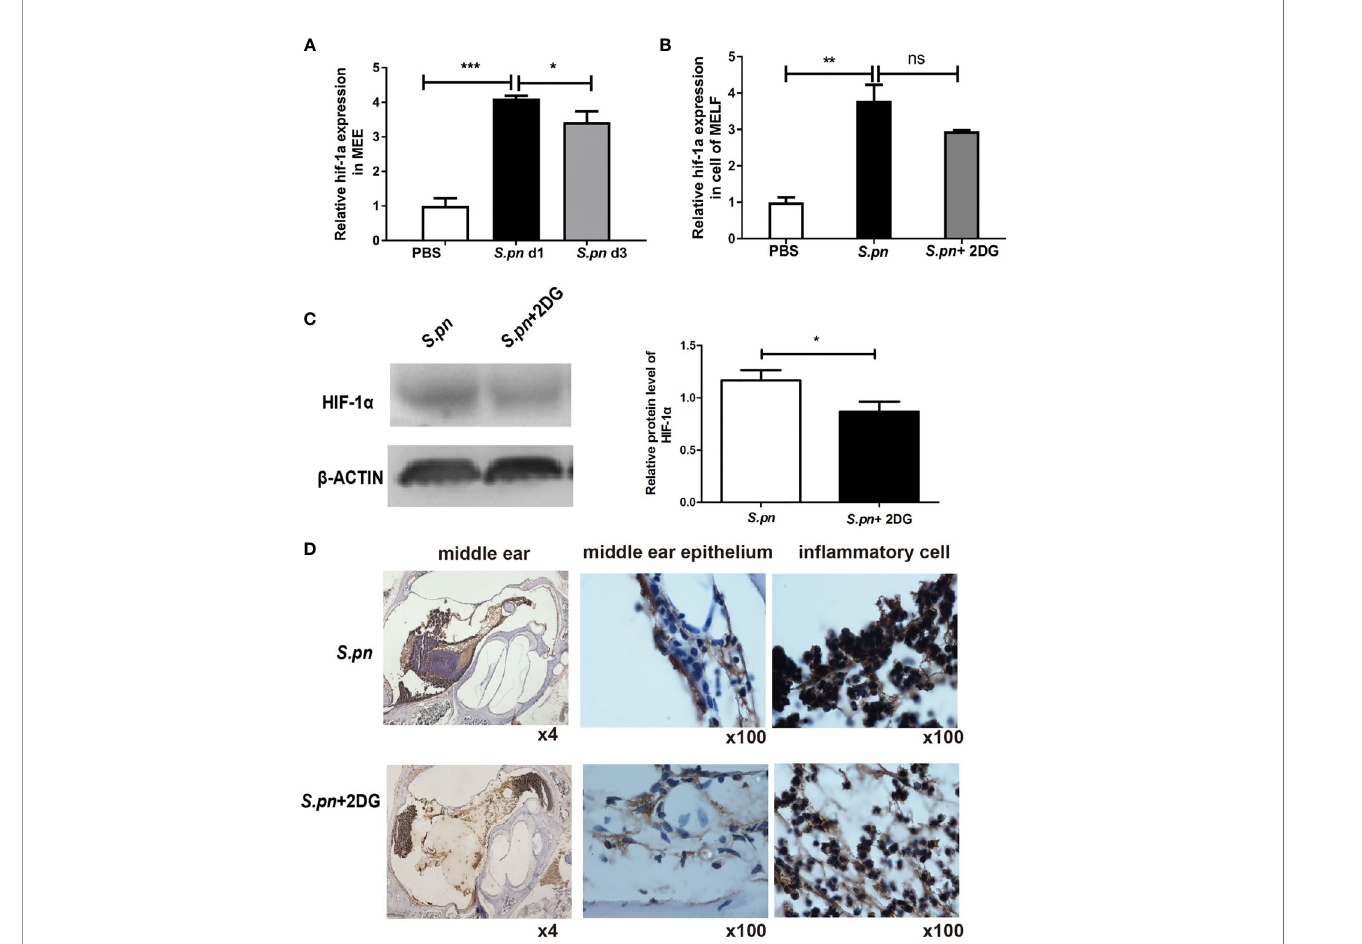
FIGURE 5 | HIF-1 a participates in glycolysis induced by S.pn infection during AOM. (A) HIF-1 a mRNA expression in MEE and (B) , in fl ammatory cells number in MEC was detected by RT-qPCR. (C) Protein level of HIF-1 a in MEE was detected by western blot assay after S.pn ± 2DG treatment at days 1 post-inoculation. (D) Protein level of HIF-1 a in MEE and in fl ammatory cells was detected by IHC. Data represent three independent experiments and are presented as mean ± SD (n = 3). *P <.05; **P <.01; ***P <.001. ns, not signi fi